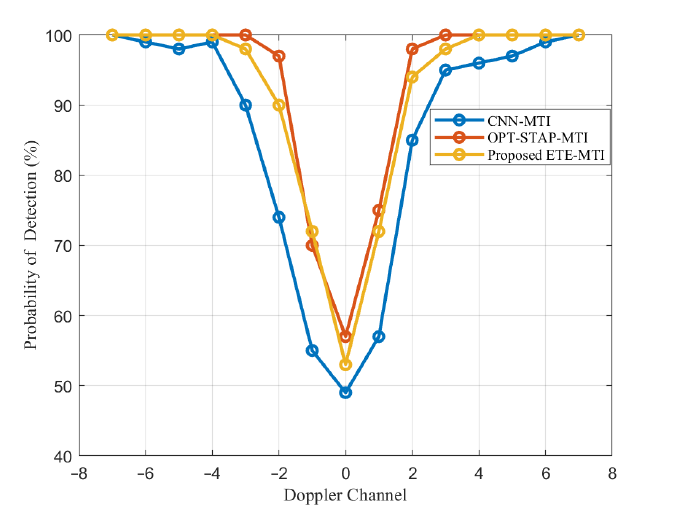
Figure 8. Performance comparison of the proposed ETE-MTI, the OPT-STAP-MTI and the CNN-MTI method